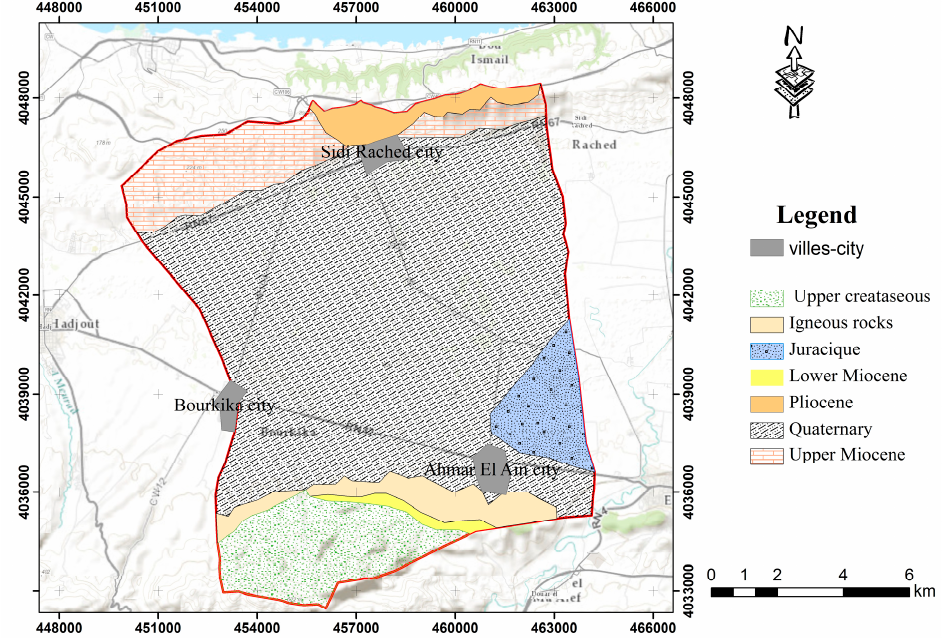
Figure 3. The geological map of the study